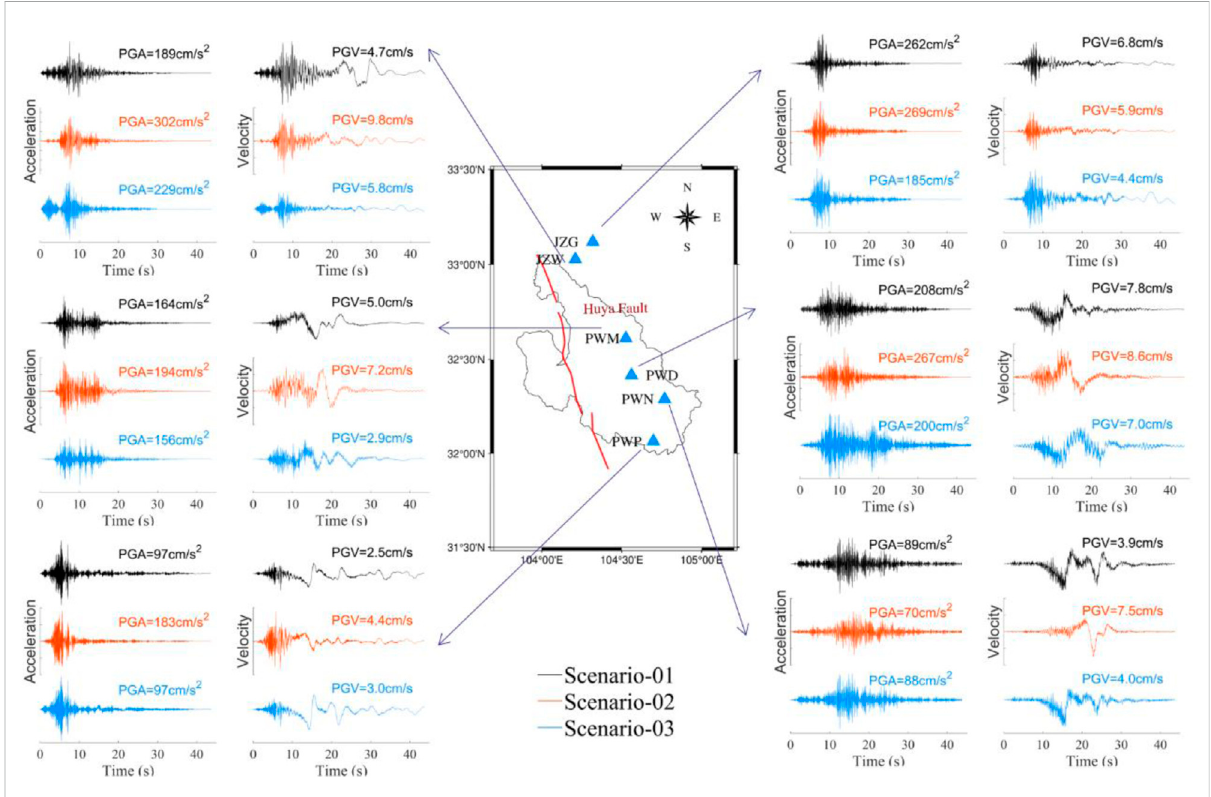
FIGURE 9 Acceleration and velocity time history of the 6 points in the partial